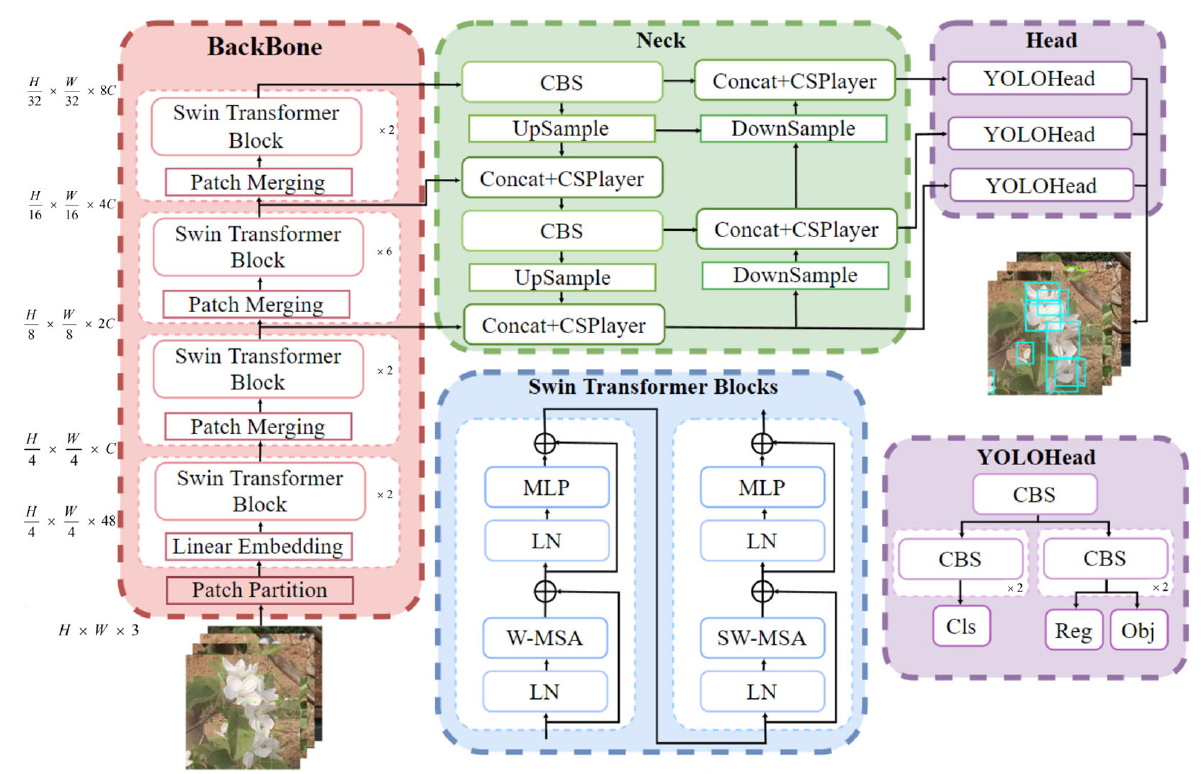
Figure 4. S-YOLO network structure.